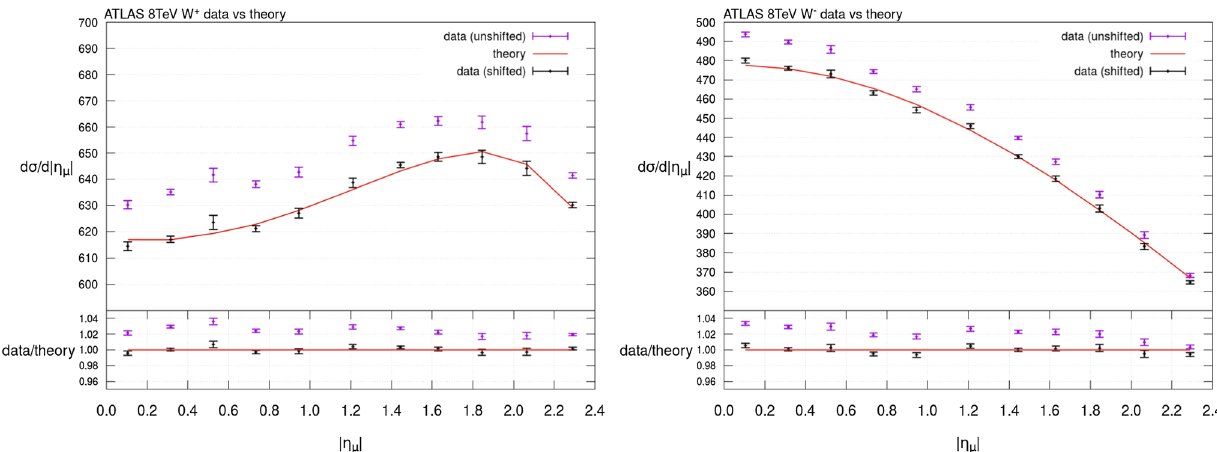
Fig. 6 Data vs. MSHT20 NNLO theory for the ATLAS 8 TeV W ± data with W + ( W − ) in the left (right) plots. The purple represents the unshifted data, the black the data after shifting via correlated and